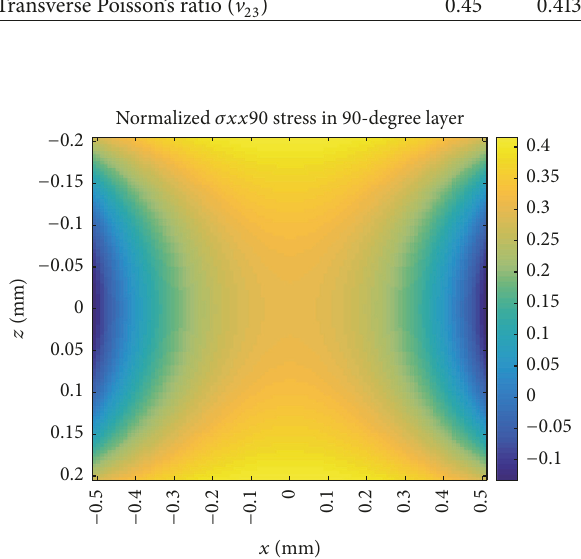
Figure 4: Normal longitudinal stress distribution 𝜎 𝑥𝑥 in 90- degree layer for a glass fiber/epoxy cross-ply [0/90] s laminate using Berthelot-modified shear-lag model [12].